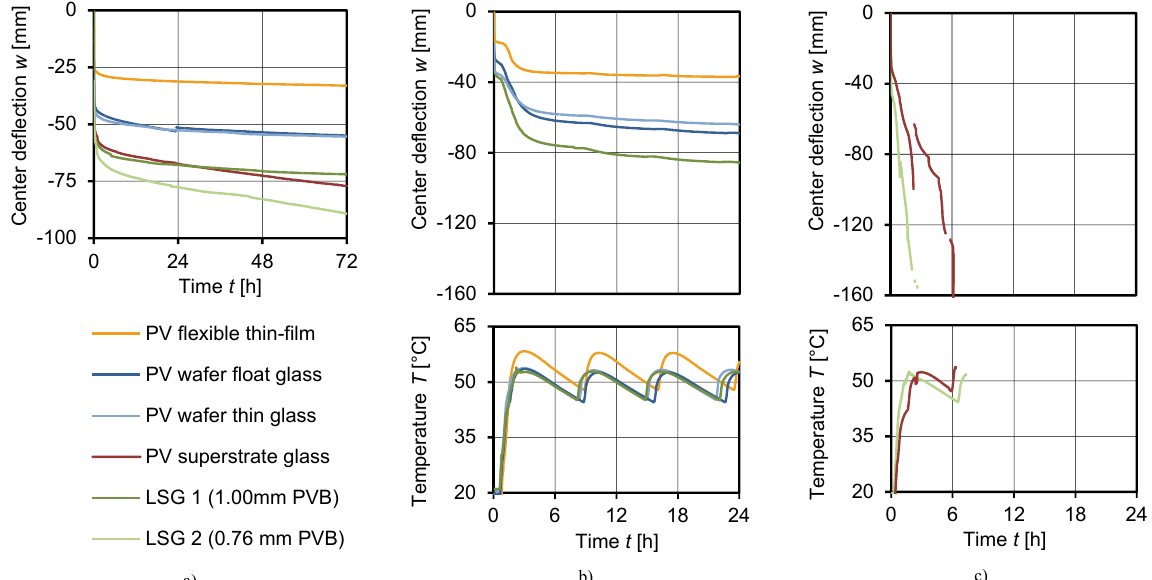
Fig. 12 Mean values of the measured center deflections a) in the winter scenario = pressure load 0.65 kN/m 2 at room temperature, b) and c) in the transitional scenario = suction load 0.325 kN/m 2 at +50